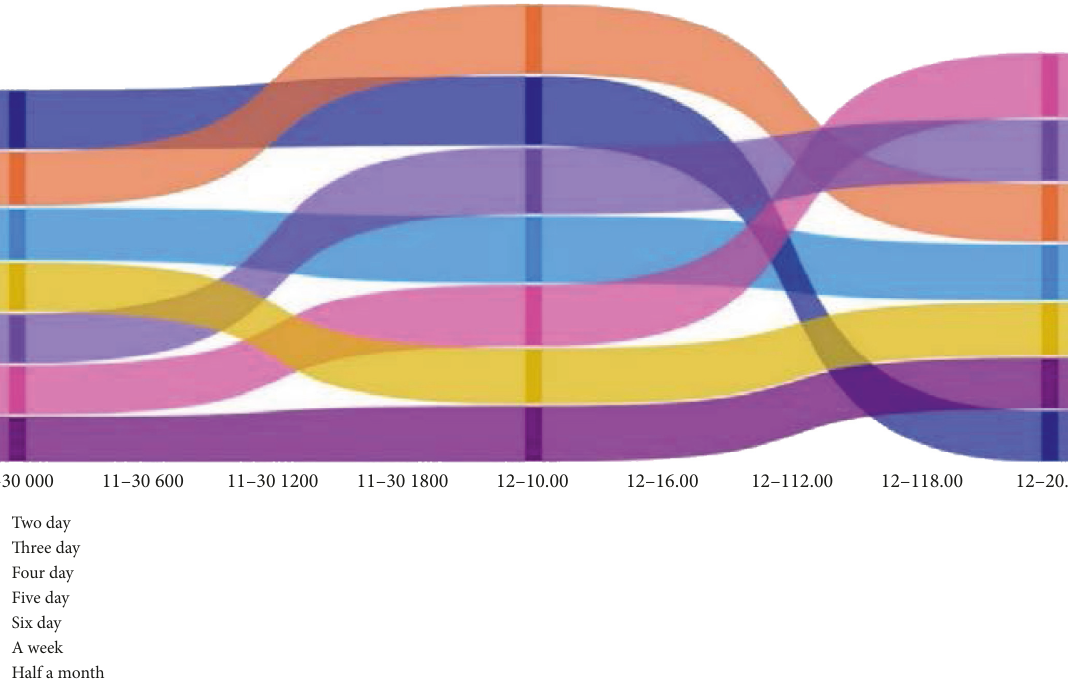
Figure 19: Time sharing user retention rate filamentary